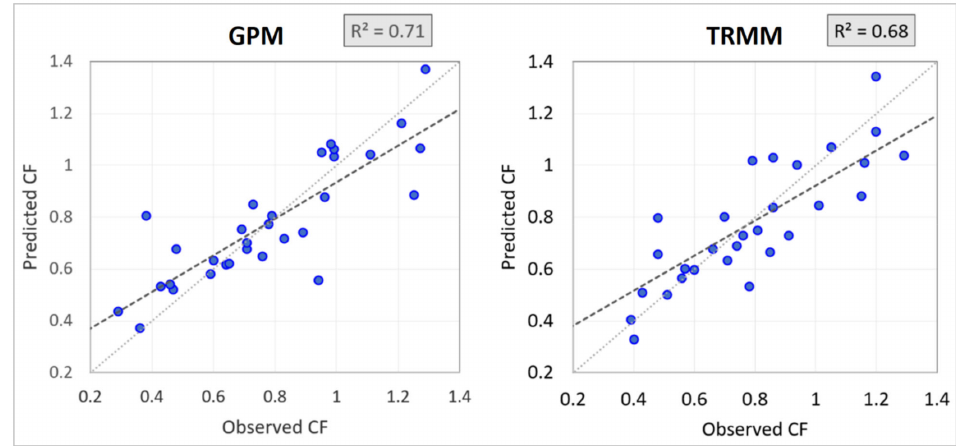
Figure 11. Comparison of the observed and predicted correction factors of GPM/IMERG and